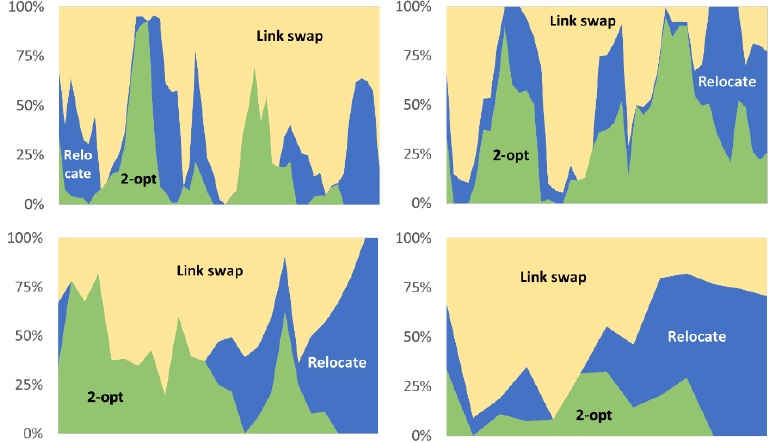
Figure 22. Productivity of the operators during the search with for 4 different O – Mopsi instances.